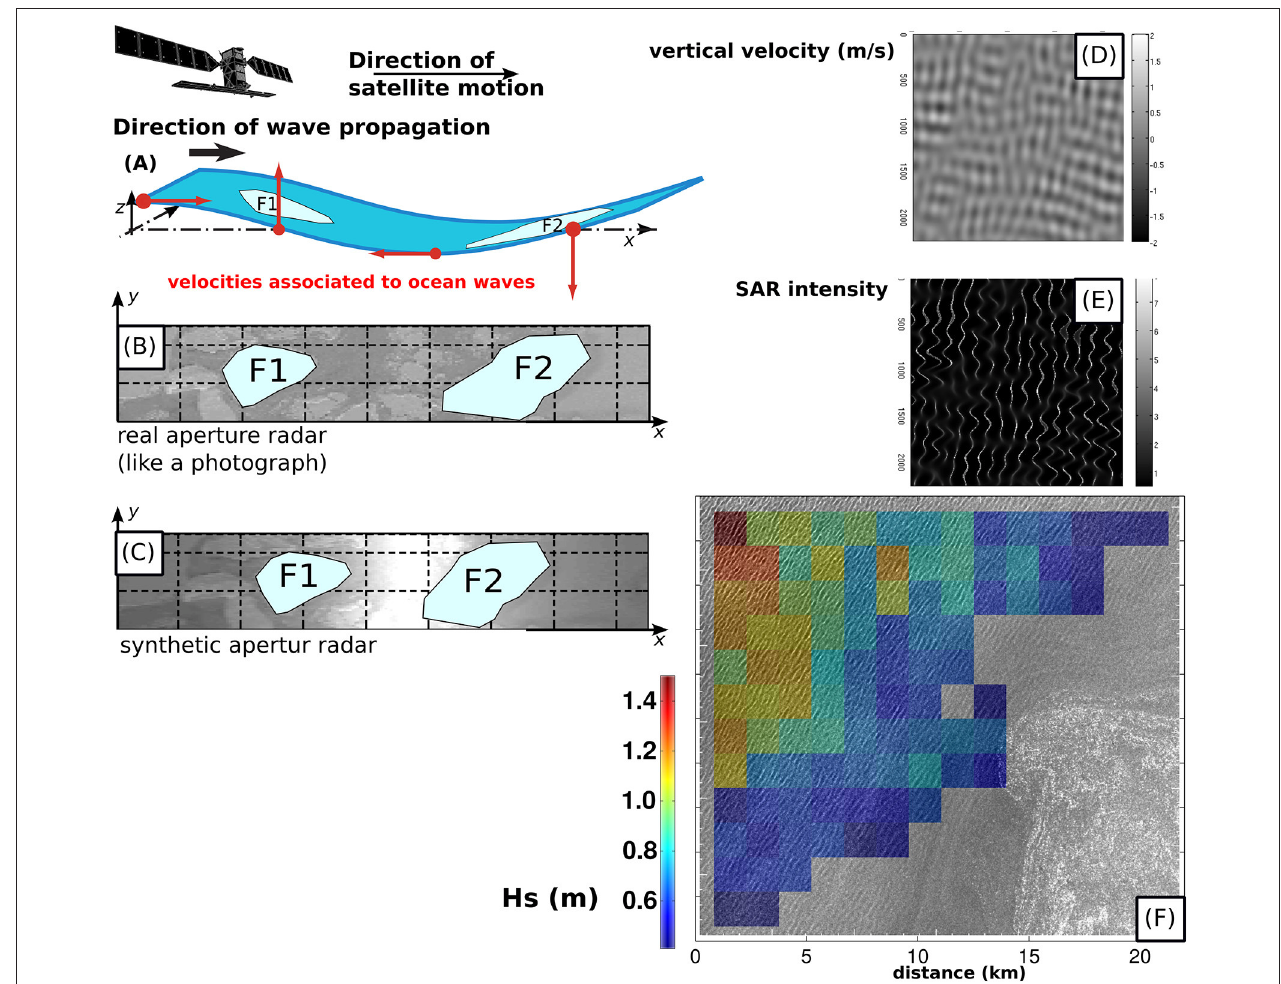
FIGURE 14 | (A) schematic illustrating the geometry of SAR observation and vertical velocities at the surface. (B) Example of a real aperture radar scene stretched into (C) a SAR scene due to varying vertical velocities in the azimuth direction: actual features such as ice floes F 1 and F 2 appear displaced in the azimuth (x) direction. (D) example of simulated vertical velocity map due to two swell trains propagating at right angles and (E) simulated SAR intensity in the case of a sea surface with uniform σ 0 . (F) Intensity map (gray shades) observed by Sentinel-1A in Southern Ocean sea ice on 03/05/2016 at 10:55:53 UTC, and overlaid map of H s in color obtained by inverting the SAR intensity pattern into a vertical velocity map. This example is further discussed in Stopa et al.